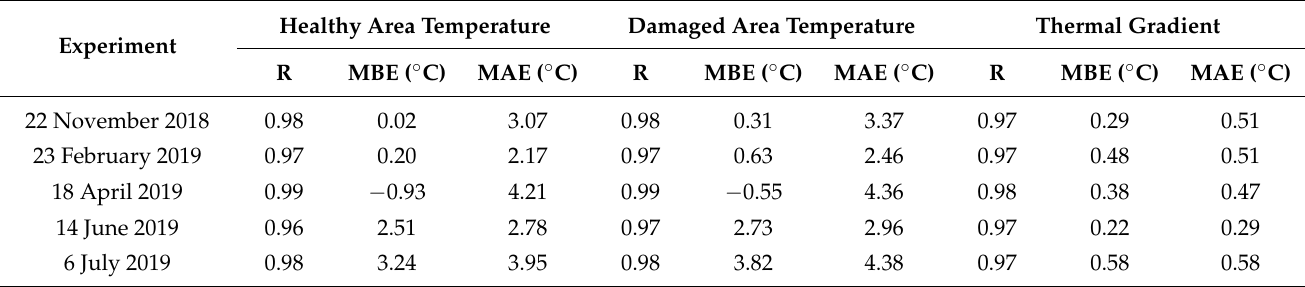
Table 3. R, MBE, and MAE for the surface temperatures and thermal gradients measured and simulated in the daily experiments.